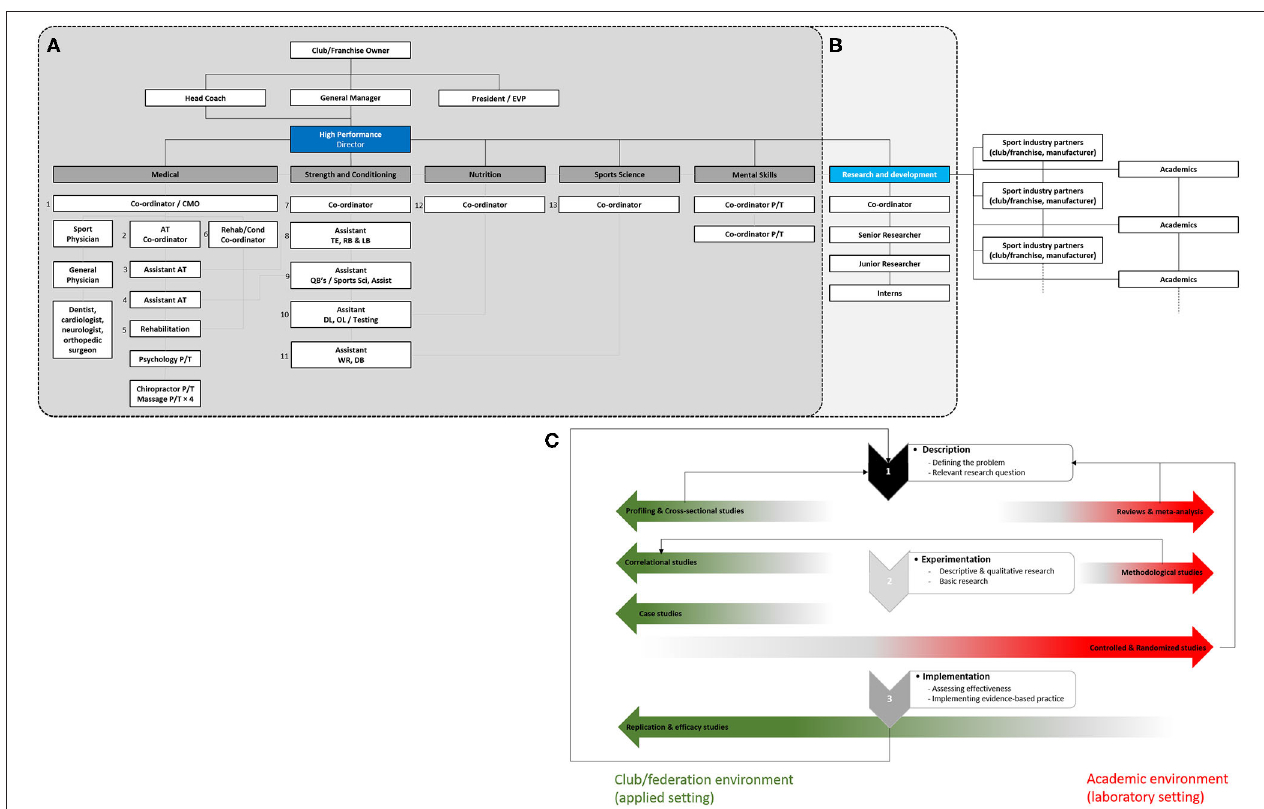
FIGURE 1 | The actual (A) and proposed (B) performance support model and its applied research process (C) . AT, athletic trainer; CMO, chief medical officer; DB, defensive back; DL, defensive line; EVP, executive vice president; LB, linebacker; OL, offensive line; P/T, physical therapist; QB, quarterback; RB, running back; TE, tight end; WR, wide